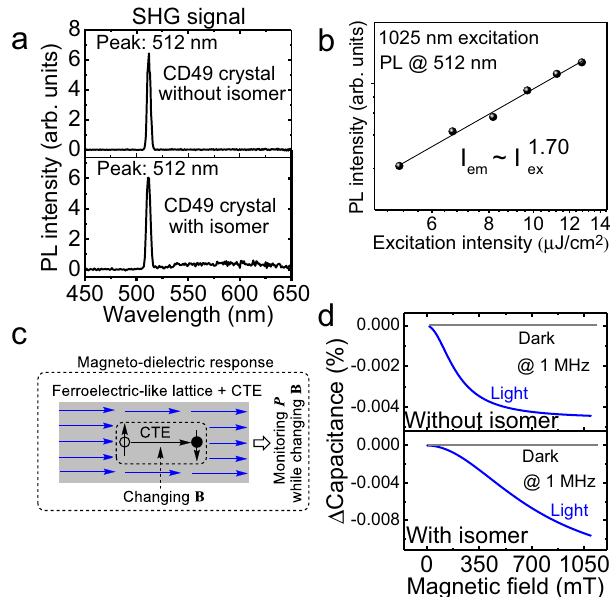
Fig. 6 Coupling between ferroelectric polarization and crystalline intermolecular charge-transfer excitons (CTEs). a SHG signals for CD49 crystals prepared with and without isomer molecules under 1025 nm excitation. b Excitation – emission power dependence for SHG signals. c Principle for using magneto-dielectric response to identify coupling between ferroelectric-like lattice and crystalline intermolecular CTE. Electrical polarization P was measured at 1 MHz, while gradually increasing magnetic fi eld B . When ferroelectric-like lattice is coupled with CTEs, disturbing CTEs by magnetic fi eld leads to a change on electrical polarization, presenting magneto-dielectric response. d Magneto-dielectric signals were measured at 1 MHz as a function of magnetic fi eld under 343 nm excitation as compared to dark